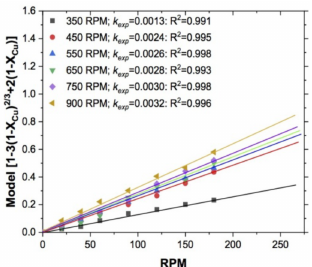
Figure 9. Copper leaching—effect of stirring rate. Apparent order of reaction n = 0.0014. Experimental conditions: 318 K, pH 10,